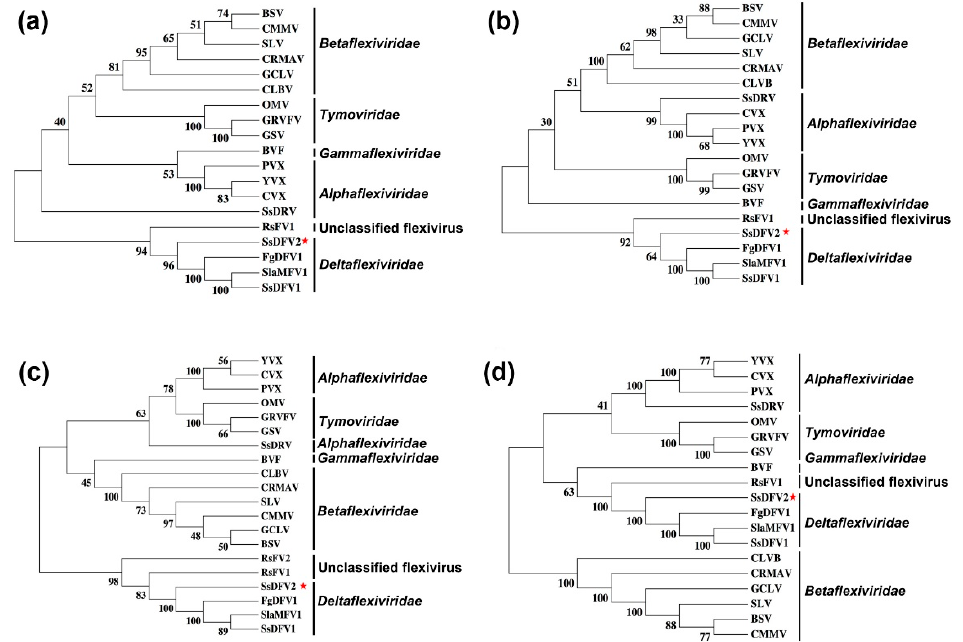
Figure 5. Phylogenetic analysis (Bootstrap concensus tree) of SsDFV2 and other selected viruses using the Neighbor joining method with 1000 bootstrap replications. Comparisons of conserved ( a ) helicase; ( b ) methyltransferase; ( c ) RdRp; and ( d ) the entire replication-associated polyprotein among members of several genera of the families Alpha- , Beta- , and Gamma- , Deltaflexiviridae , and unclassified tymoviruses. The data coverage percentage (support out of 1000 bootstrap replications) is shown by the numbers on the left of branches. The position of novel virus SsDFV2 is shown by red asterisks. Abbreviations of virus names and sequence accession numbers are as indicated in Table 2.